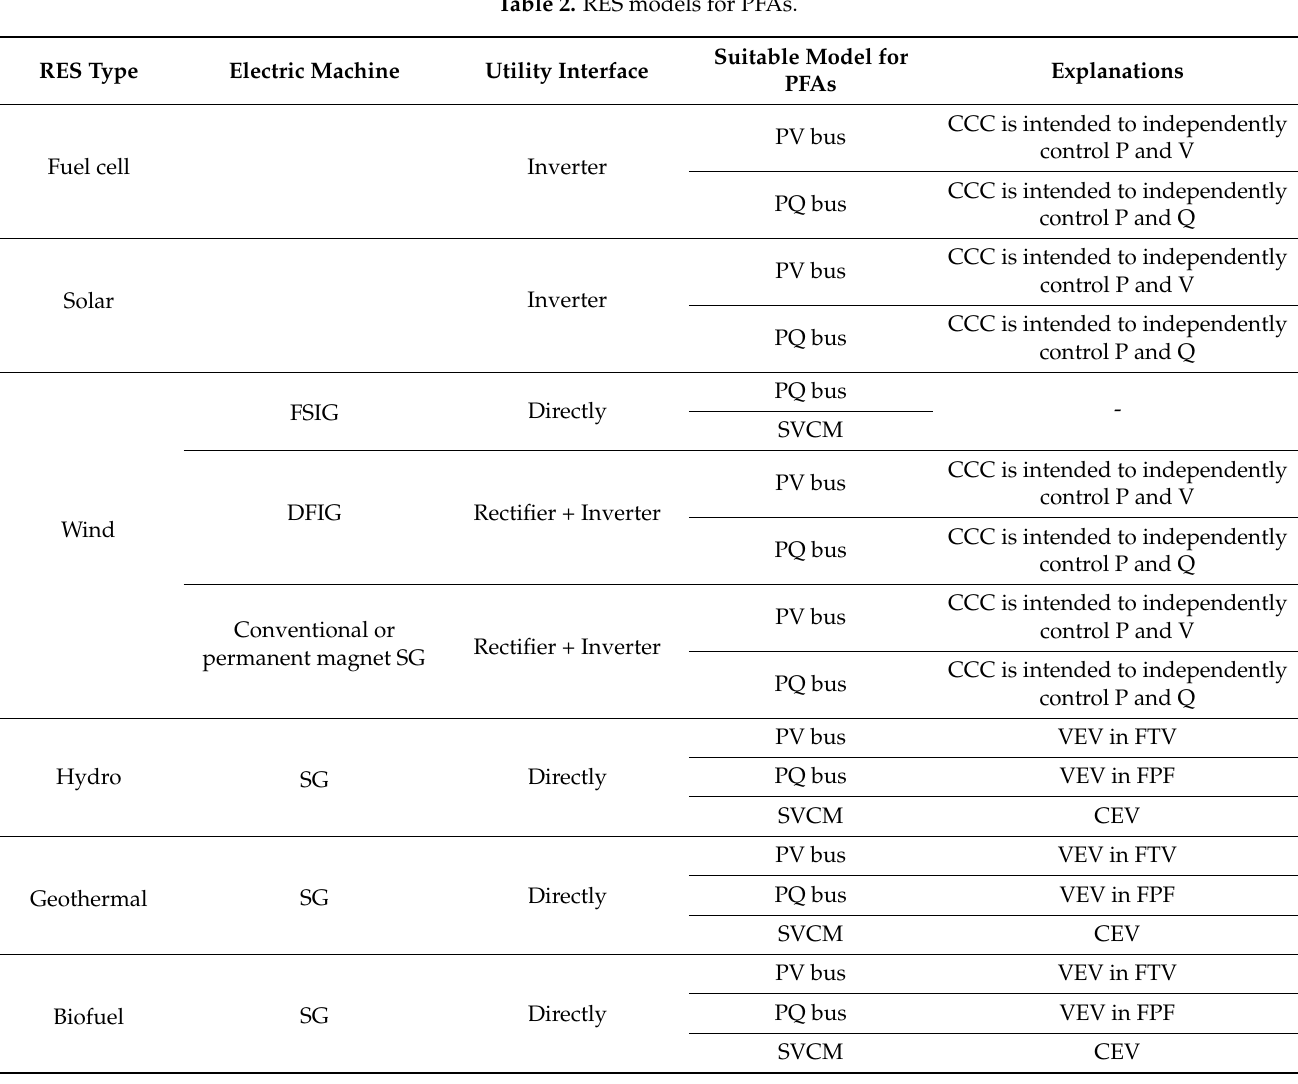
Table 2. RES models for